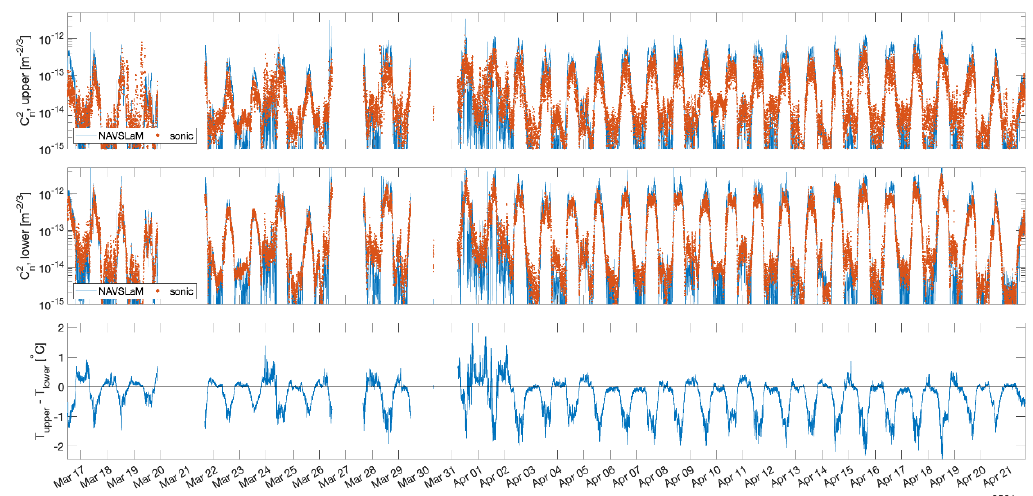
Figure 2. The upper two plots show overall C 2 n estimates from NAVSLaM (blue curves) and CSAT3 sonic anemometers (red dots), for the entire period of data collection from 16 March 2021 to 20 April 2021. The bottom plot shows the mean air temperature difference between the upper and lower sonic locations.